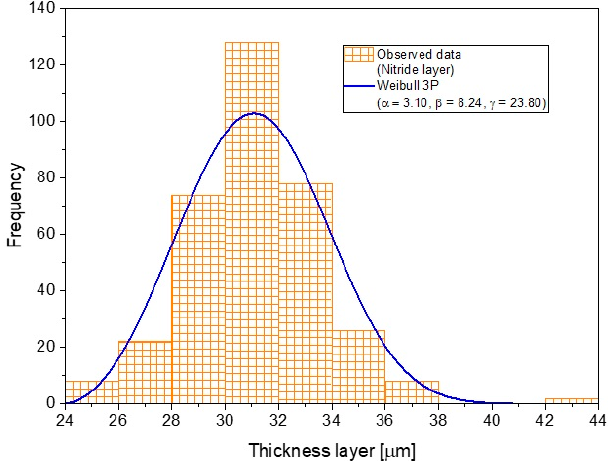
Figure 12. Carbide layer thickness histogram fitted to Weibull 3P.